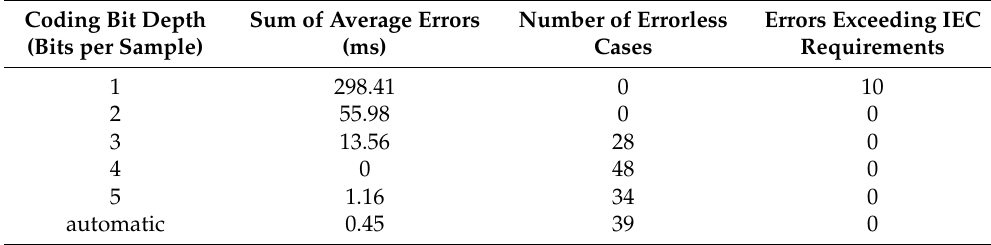
Table 3. Watermarking performance with use of different watermark coding bit depth value (48 iterations for 4 intervals, six wavelets types and textual or numerical watermark).